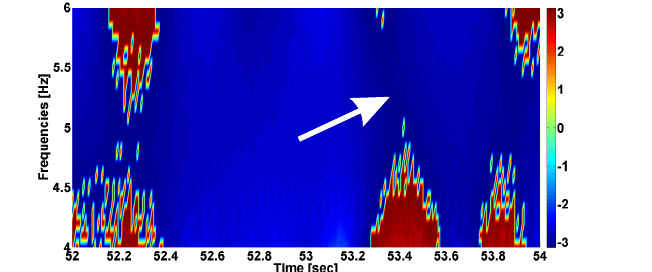
Figure 6. Phase shift of cross-wavelet spectrum given in Figure 5. The abscissa axis is time in seconds; the ordinate axis is frequency in Hz. White arrow indicates coordinates of the local maximum in the cross-wavelet